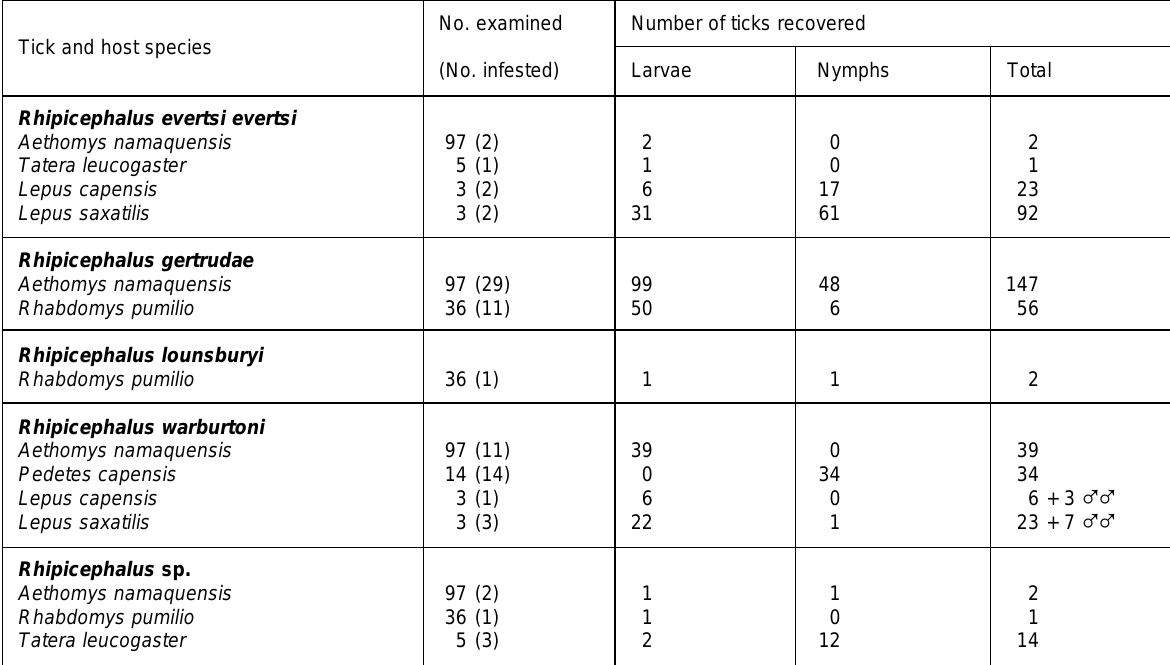
TABLE 3 Rhipicephalus species on small mammals in Free State Province No. examined Number of ticks recovered Tick and host